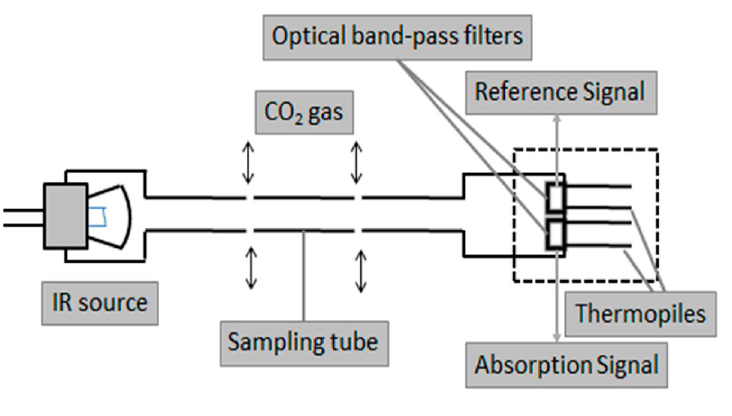
Figure 13. Internal structure of an NDIR CO 2 sensor. Constituted by an IR lamp, a perforated pipe in which light interacts with CO 2 molecules in the air, and thermopiles provided with optical bandpass windows. Adapted from